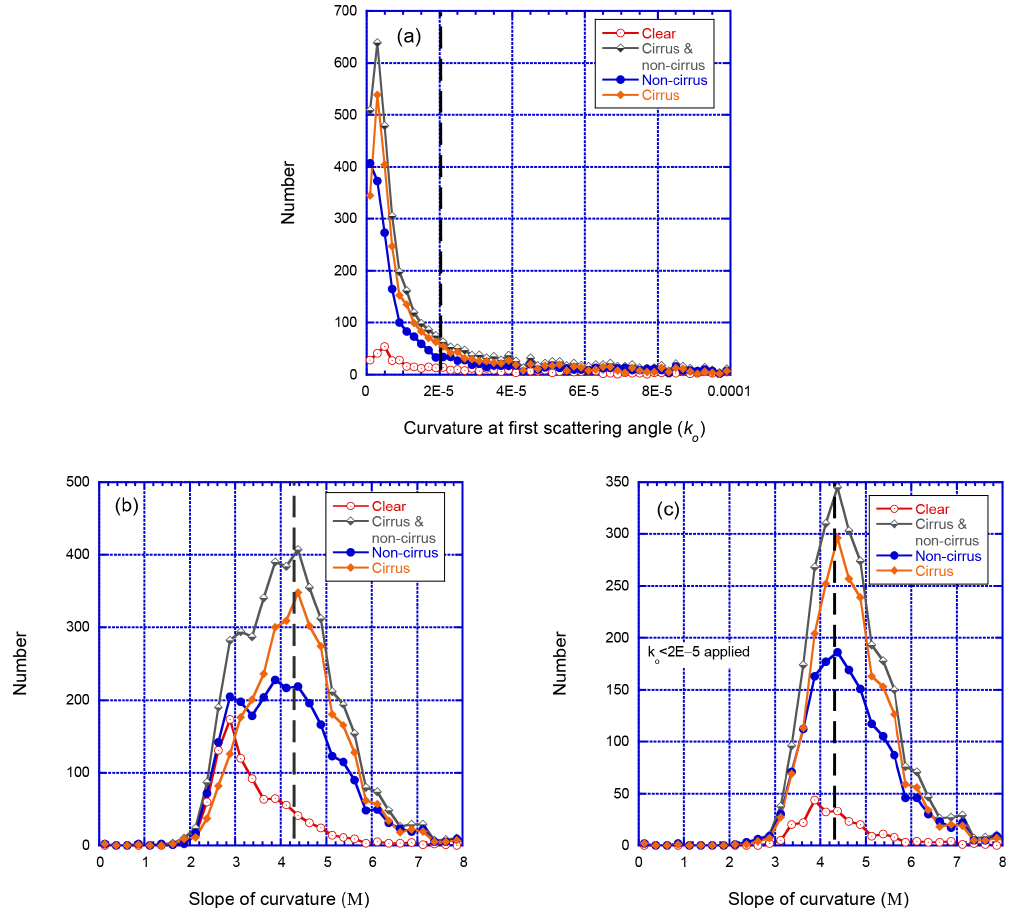
Figure 5. Similar to Fig. 4, except for Singapore (lat 1.29, long 103.78) from 2009 to 2013.